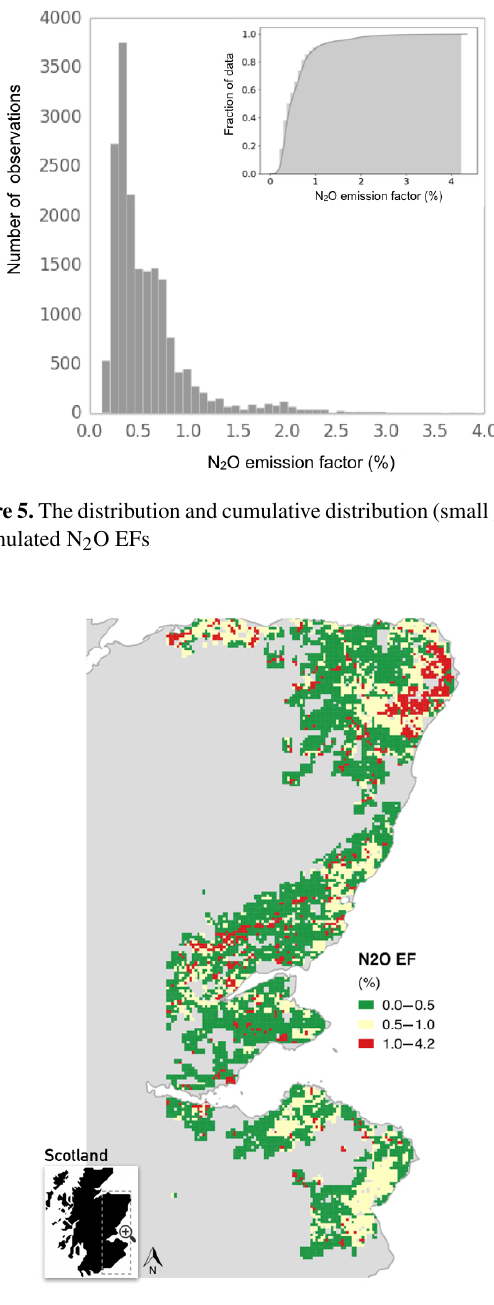
Figure 6. Geographic distribution of simulated N 2 O EFs in eastern